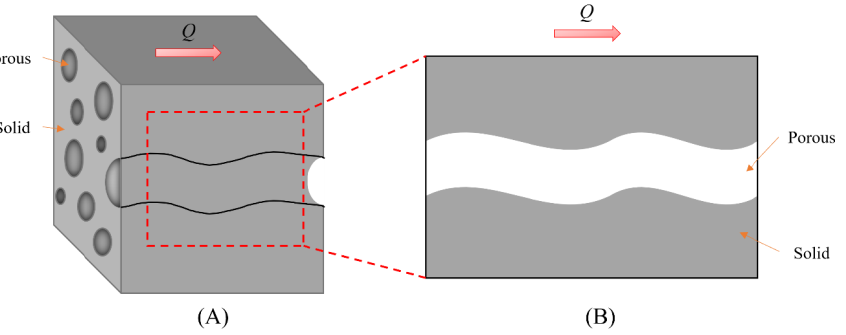
Figure 1. ( A ). Simplified model of pore structure space of the porous materials. ( B ). Representation unit on the longitudinal section.